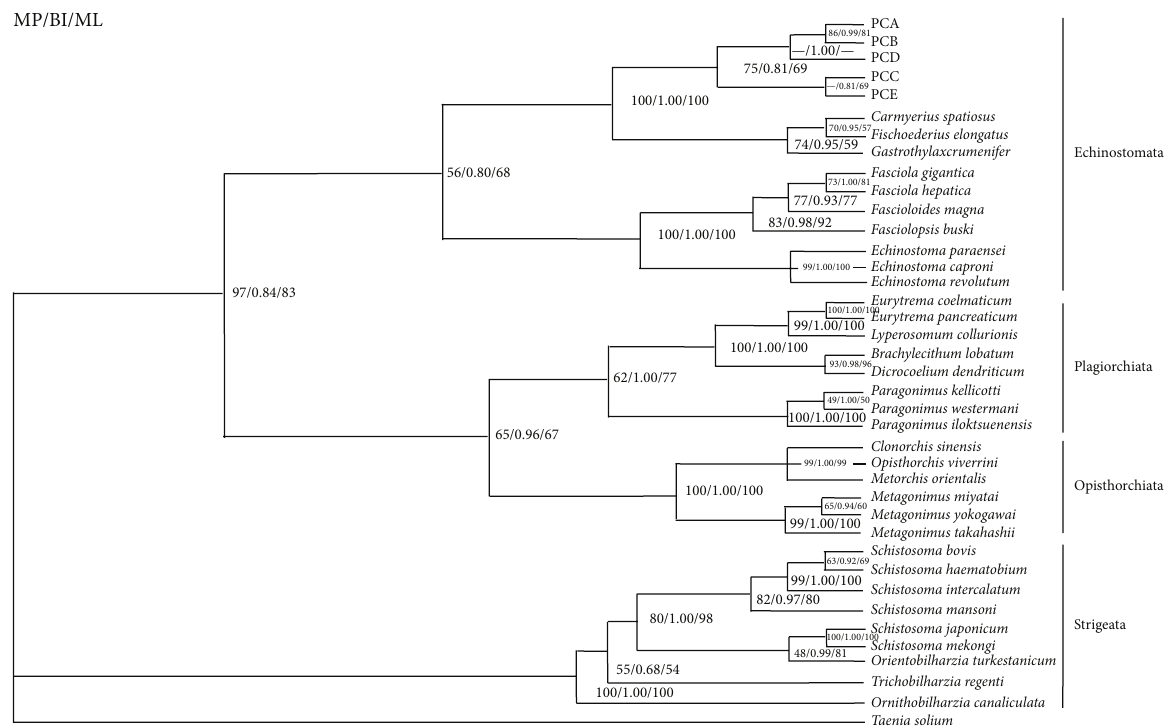
Figure 4: Inferred phylogenetic relationship among representative trematodes. The 18S rDNA sequences of Paramphistomum cervi were analyzed utilizing maximum parsimony (MP), Bayesian inference (BI), and maximum likelihood (ML), using Taenia solium (GenBank accession number GQ260091) as the outgroup. The numbers along branches indicate posterior probabilities and bootstrap values resulting from different analyses in the order: